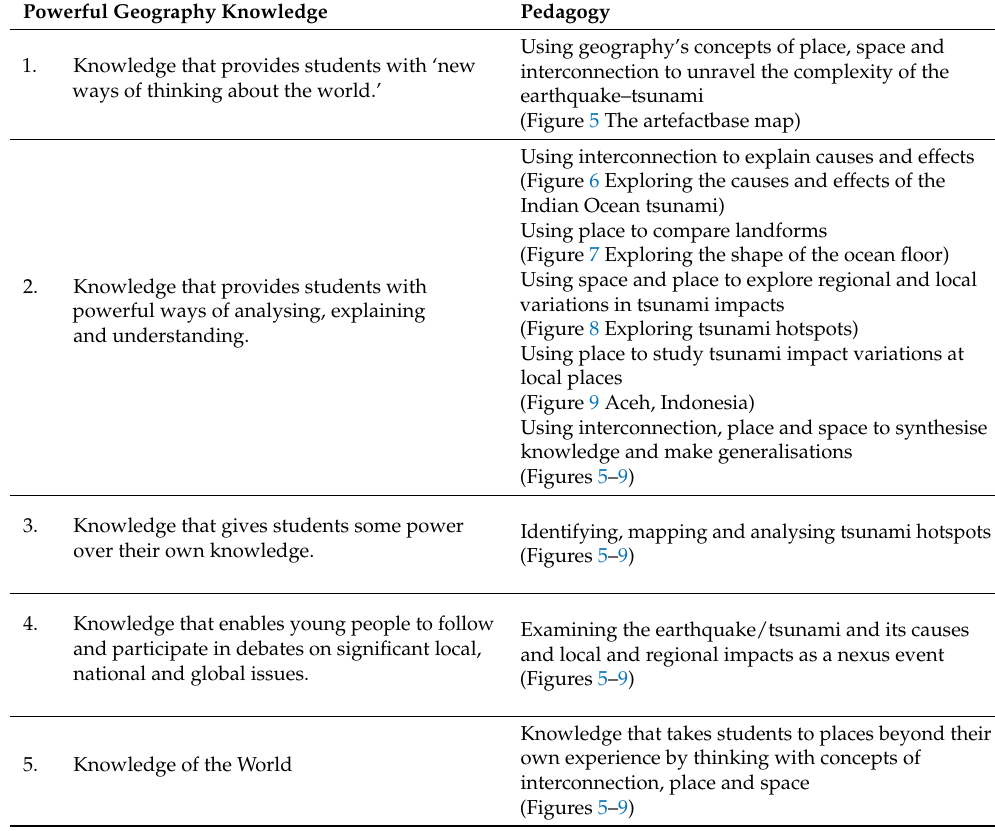
Table 3. Constructing powerful geography knowledge with